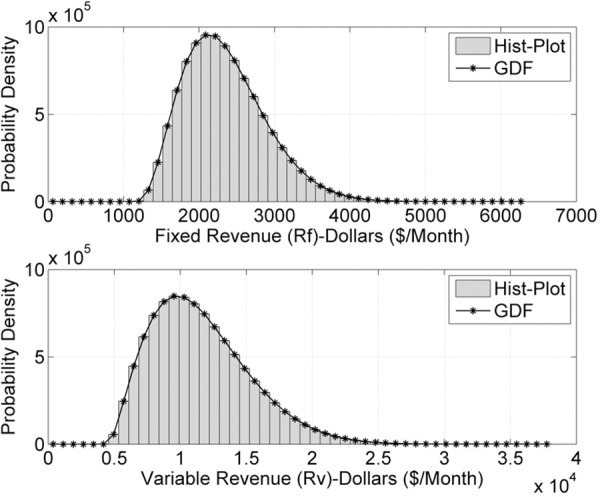
RF(t) and Rv(t) for n = 107 samples.